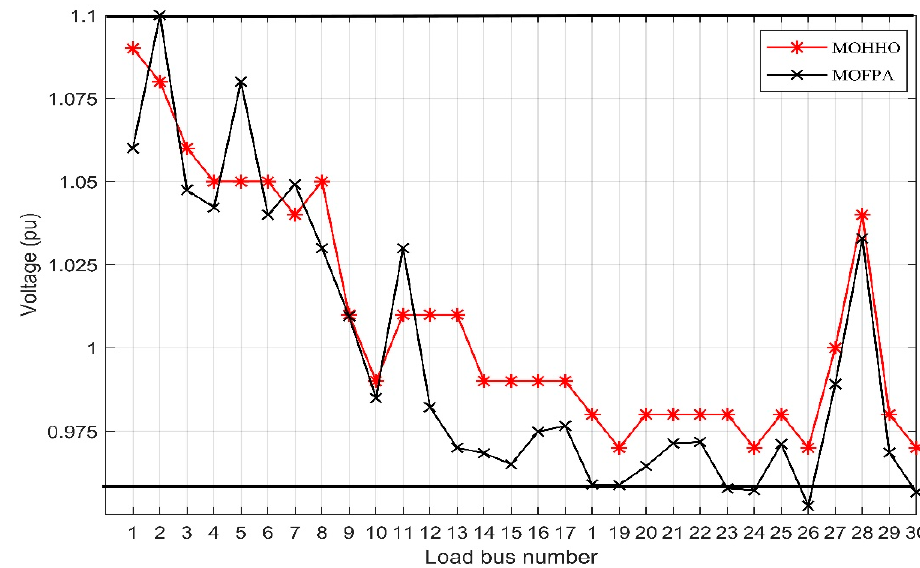
Figure 13. Load bus voltage profiles for worst VD values utilizing the two optimizations in Scenario II.